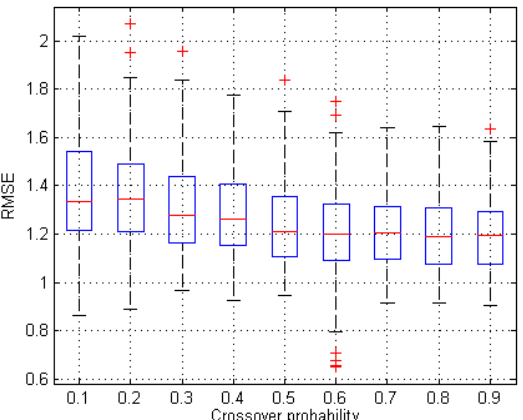
Figure 3. Box plots of the RMSE with different crossover probability.